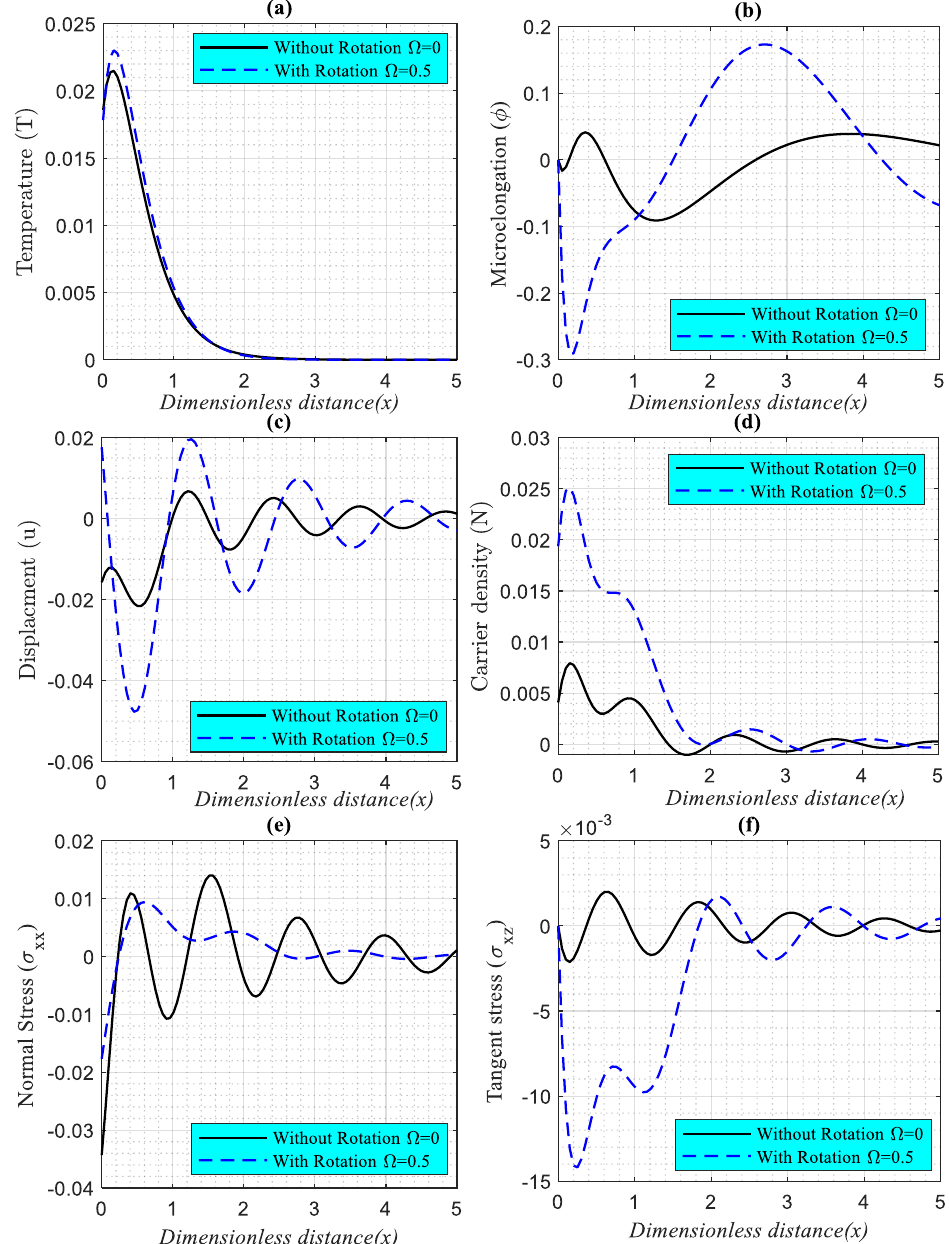
Figure 4. a-f. The variations the main physical fields versus the horizontal distance in case of the GL model with rotation field influence and without rotation field influence.